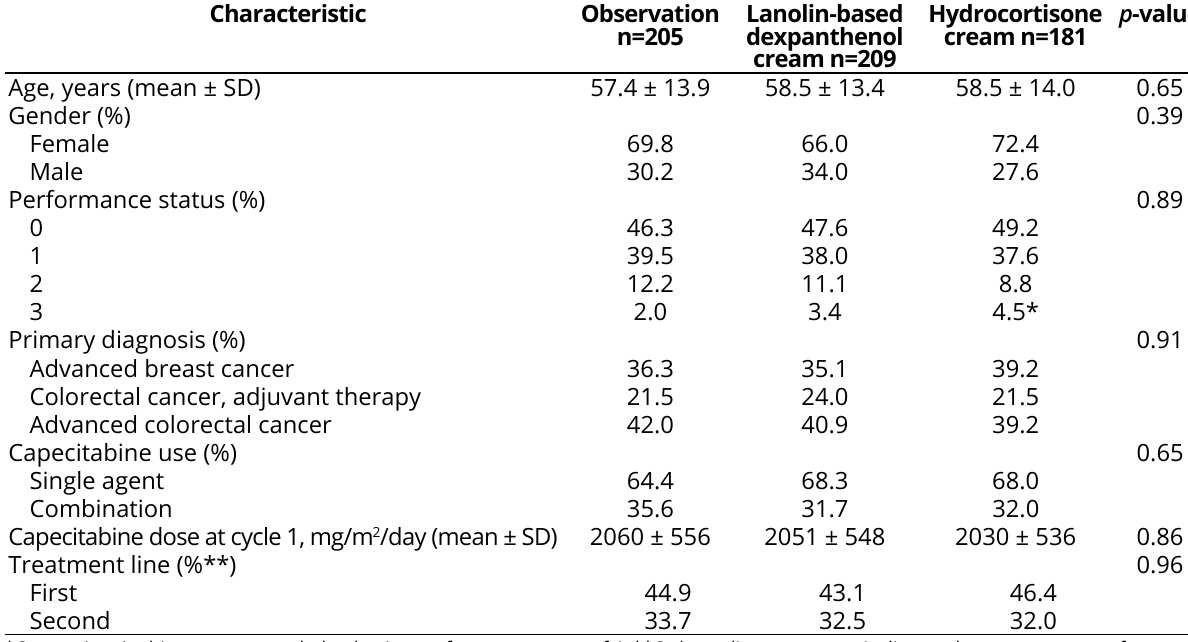
Table 1. Baseline characteristics of patients.